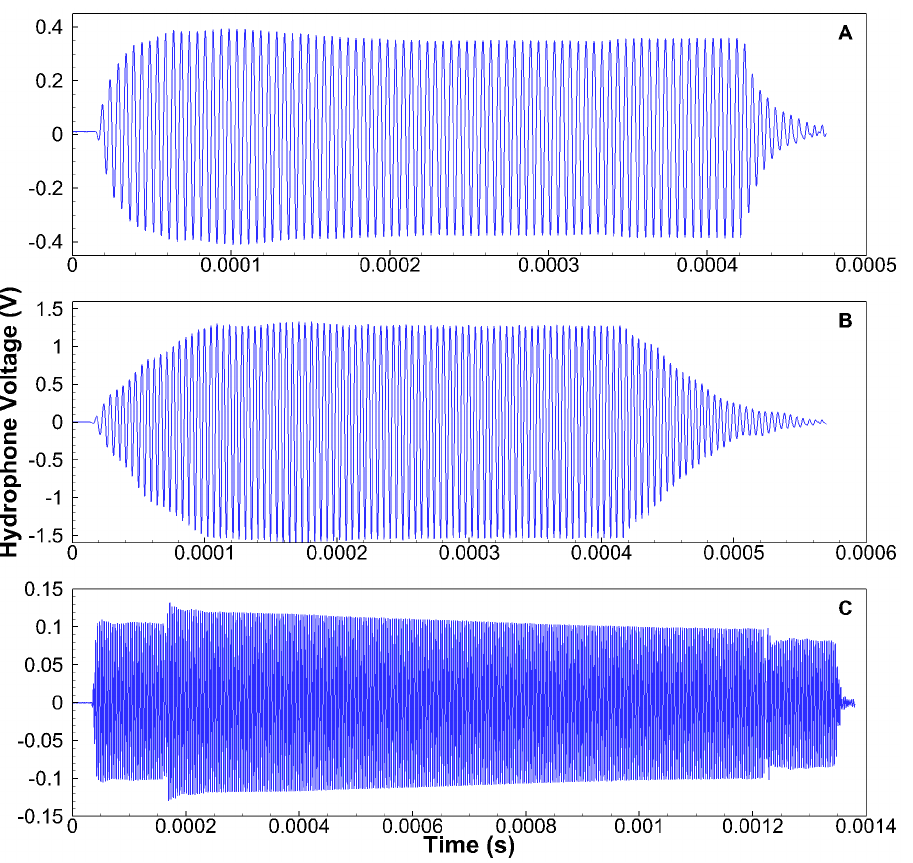
Figure 1. Sample raw waveforms collected for each sonar at a distance of approximately 20 m. A . Kongsberg (22 m); B . BioSonics (16 m); C . Imagenex (20 m).